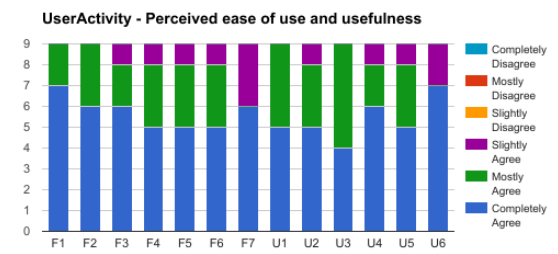
Fig. 11. T4 UserActivity - Perceived ease of use and usefulness.